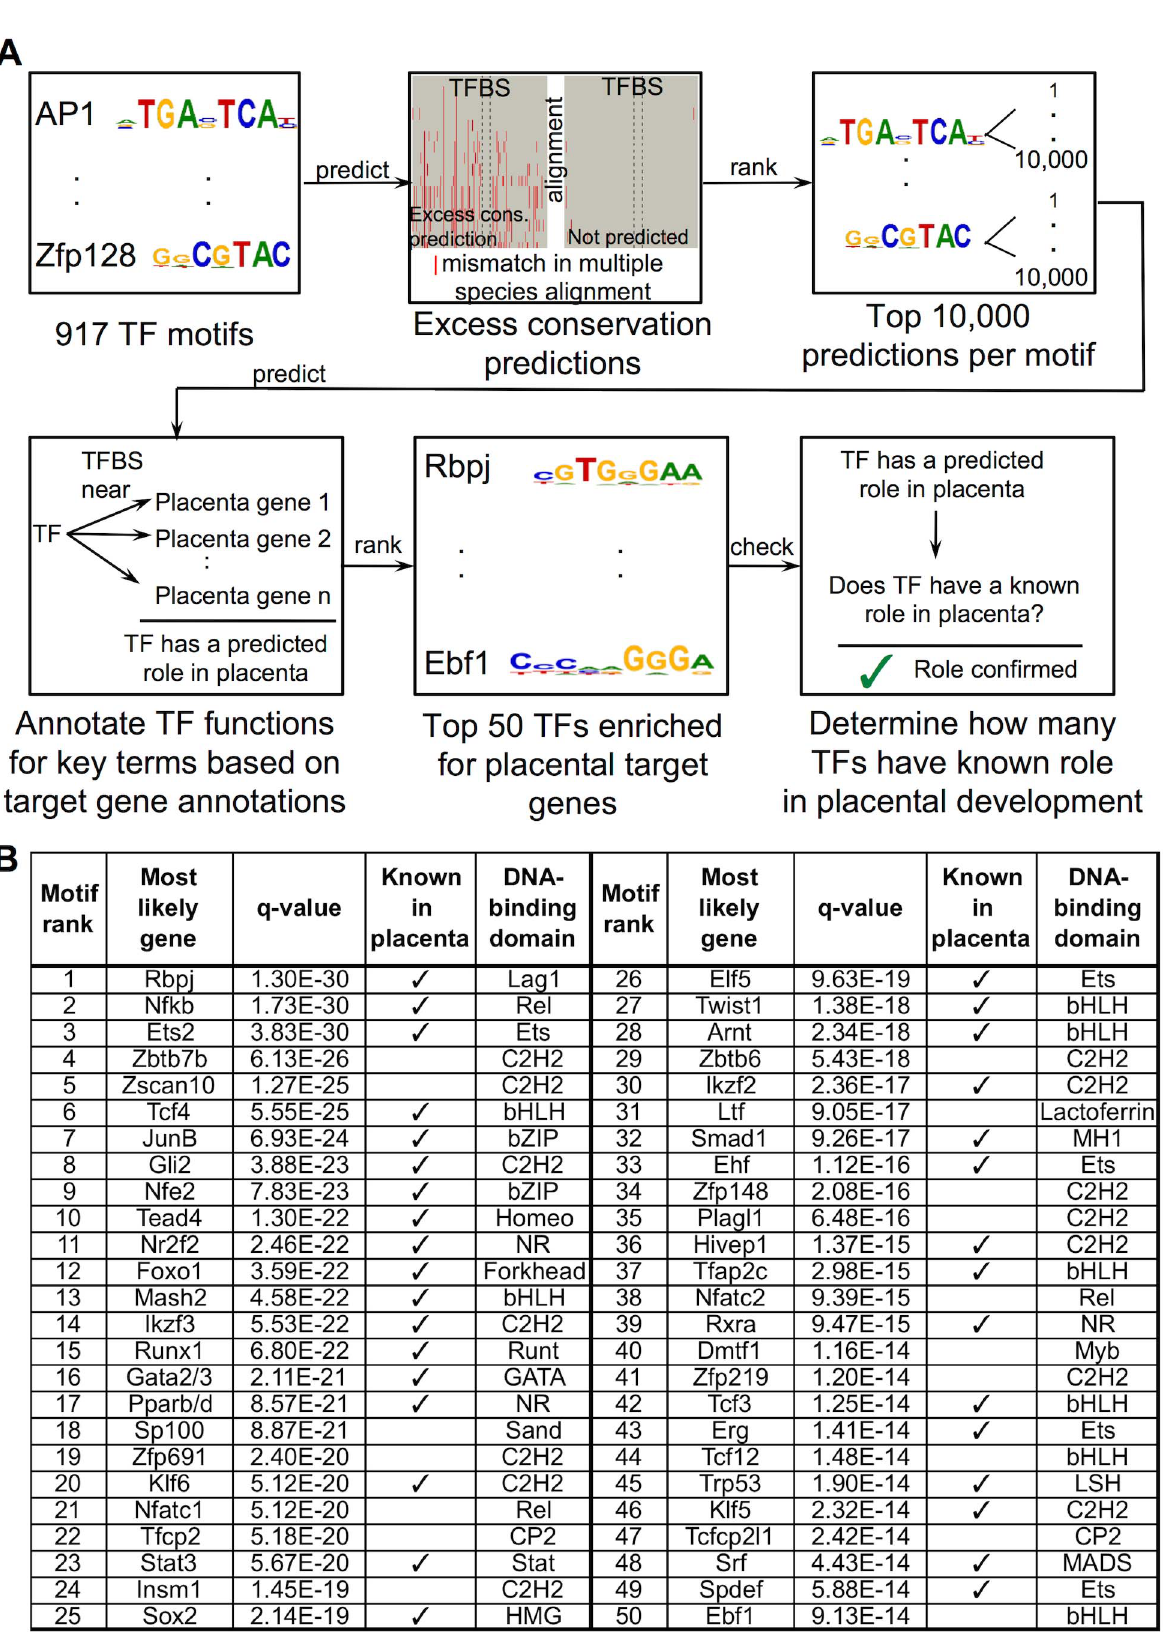
PLOS Computational Biology | www.ploscompbiol.org 3 January 2014 | Volume 10 | Issue 1 |